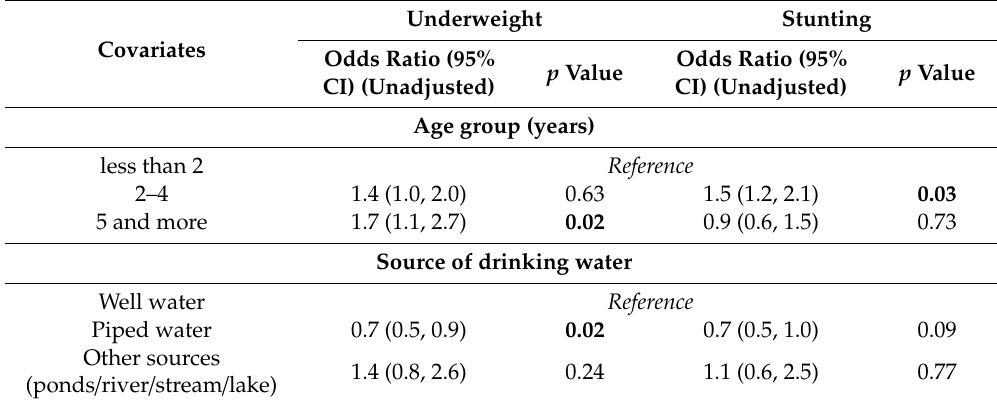
Table 4. Factors associated with underweight and stunting among children with CP in Vietnam (unadjusted